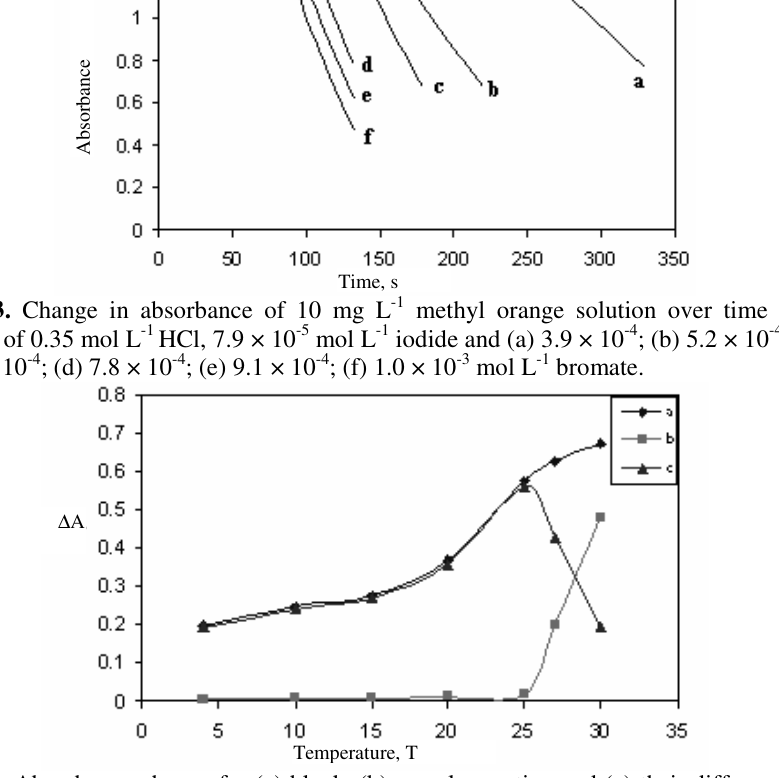
Figure 4. Absorbance change for (a) blank, (b) sample reaction and (c) their difference as a function of temprature, conditions: bromate, 6.5 × 10 -4 mol L -1 ; HCl, 0.35 mol L -1 ; iodide, 7.9 × 10 -5 mol L -1 ; methyl orange, 10 mg L -1 ; t = 60